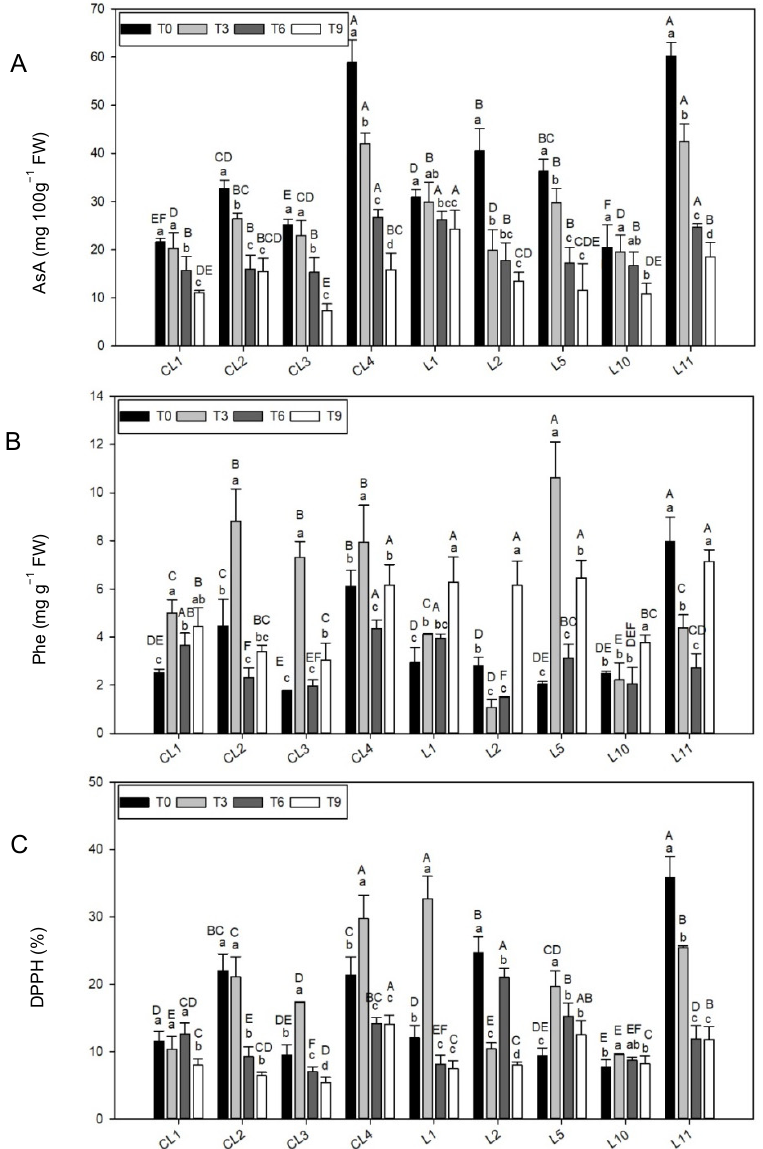
Figure 3. The ( A ) ascorbic acid (AsA), ( B ) phenol (Phe) concentrations and ( C ) antioxidant capacity (DPPH) in the nine lettuce varieties evaluated at 0 (T0), 3 (T3), 6 (T6) and 9 (T9) days after conservation under chamber conditions. Values are the mean ± SE of four replicates per landrace. The mean is subjected to a one-way ANOVA. Different capital and lowercase letters indicate significant differences between varieties and development stages, respectively, at p < 0.05 by the LSD test. FW: Fresh weight.